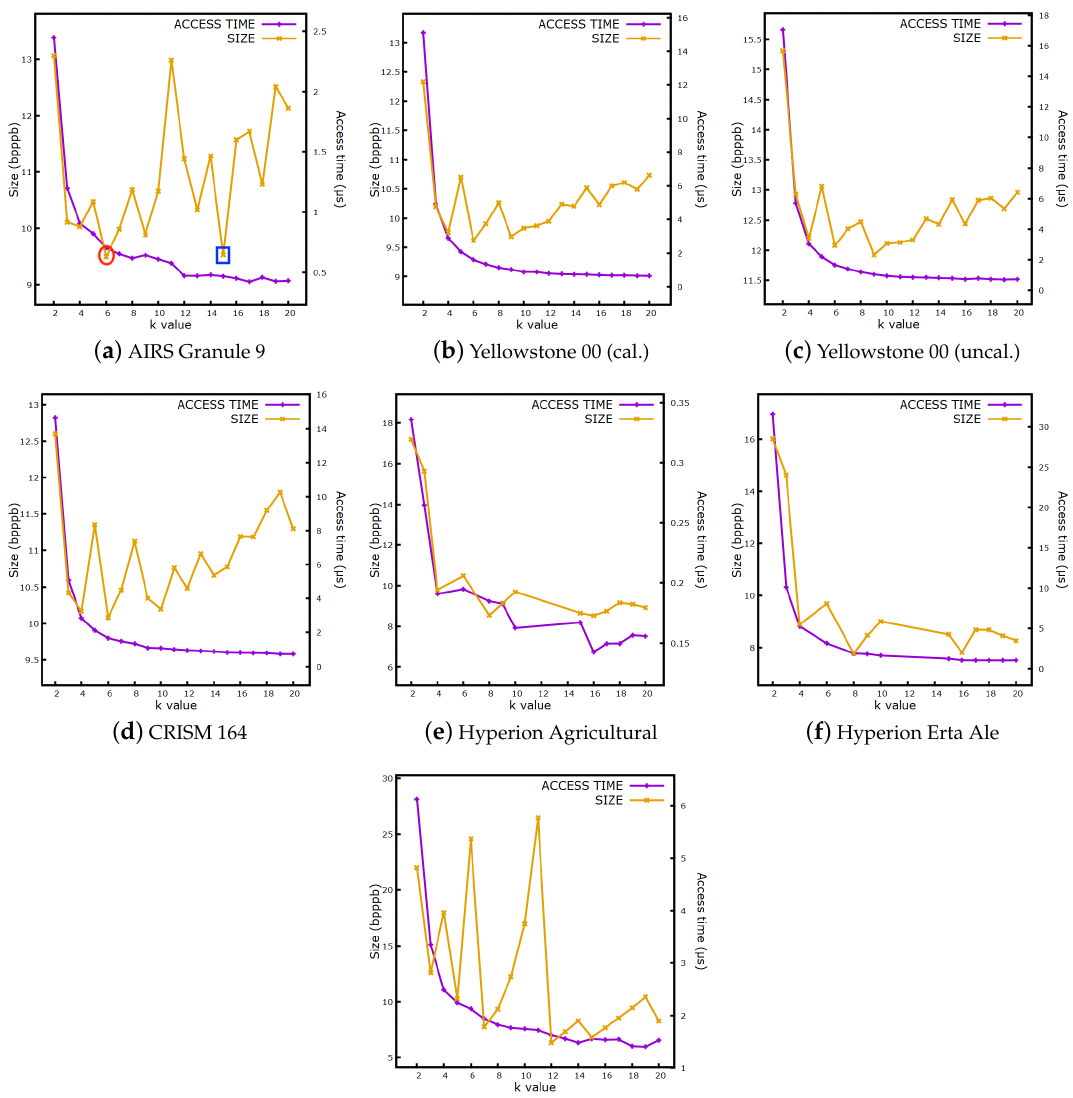
Figure 6. A comparison of the storage size (bpppb) and access time ( µ s) for different k values of k 2 -raster built from scenes in our datasets. Access time is the average time of 100,000 consecutive queries. For AIRS Granule 9, the best value is marked with a red circle, and the optimal value is marked with a blue